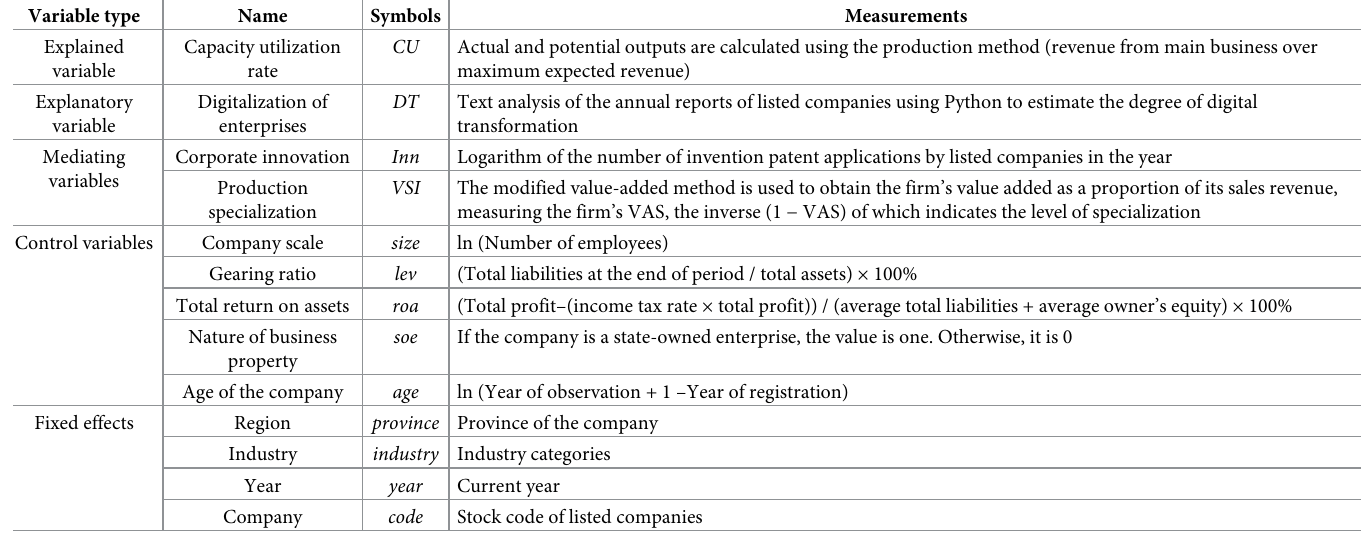
Table 1. Variable